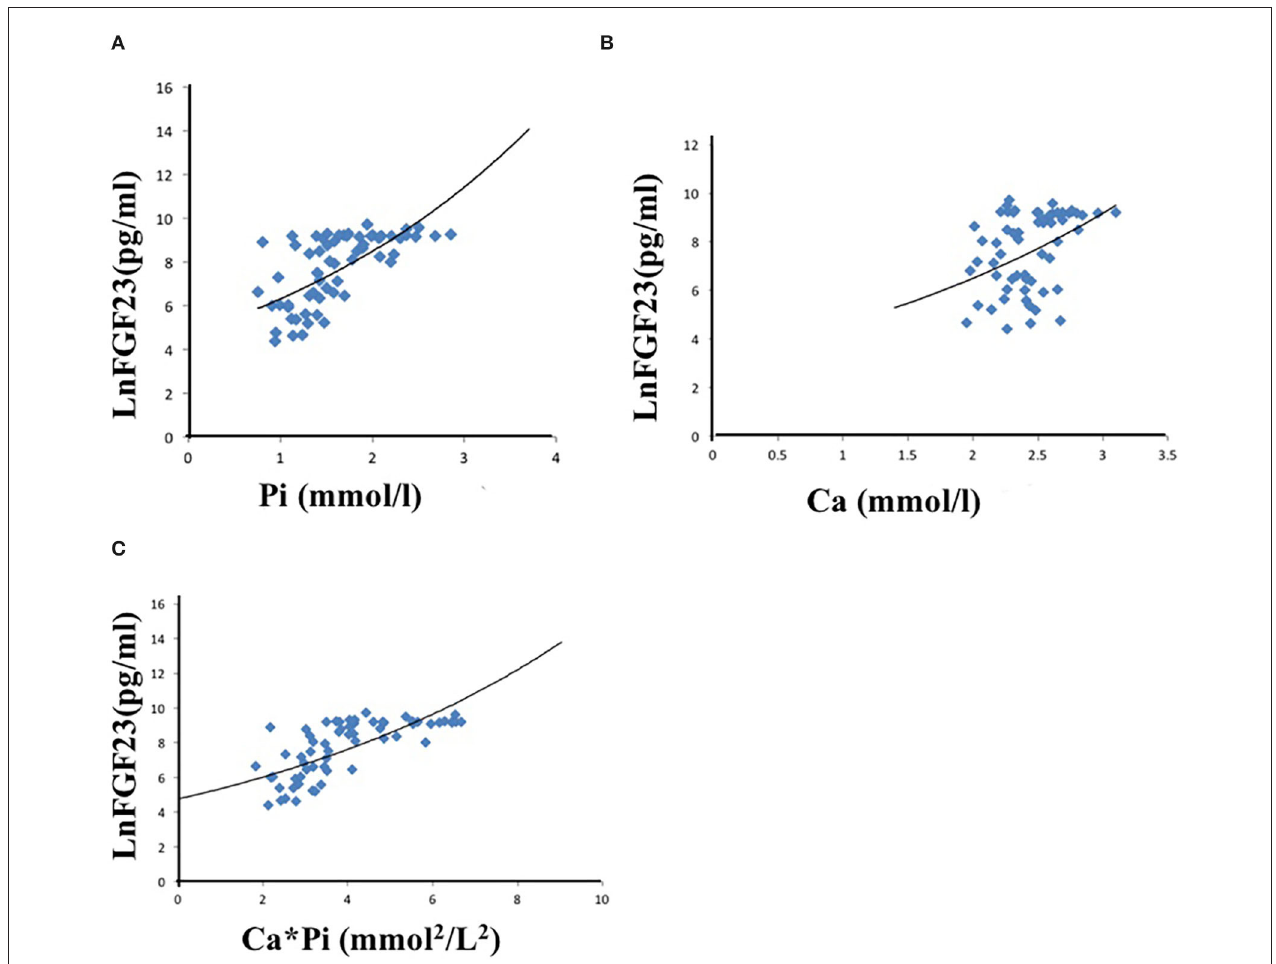
FIGURE 1 | Univariate linear correlation between phosphate (A) , calcium (B) , calcium-phosphate product (C) , and FGF23.